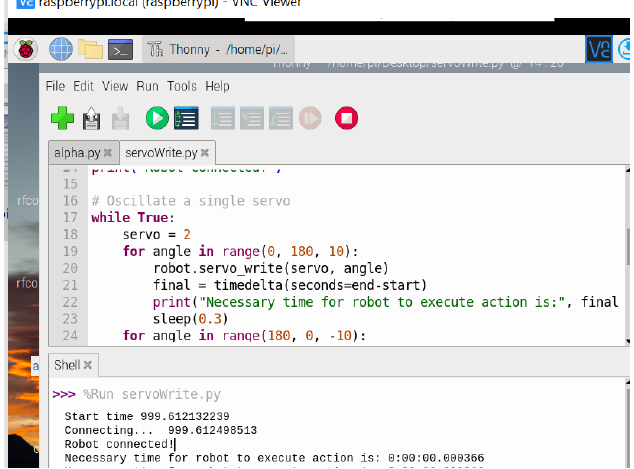
Figure 20. Execution time for Alpha 1P robot with Raspberry Pi.